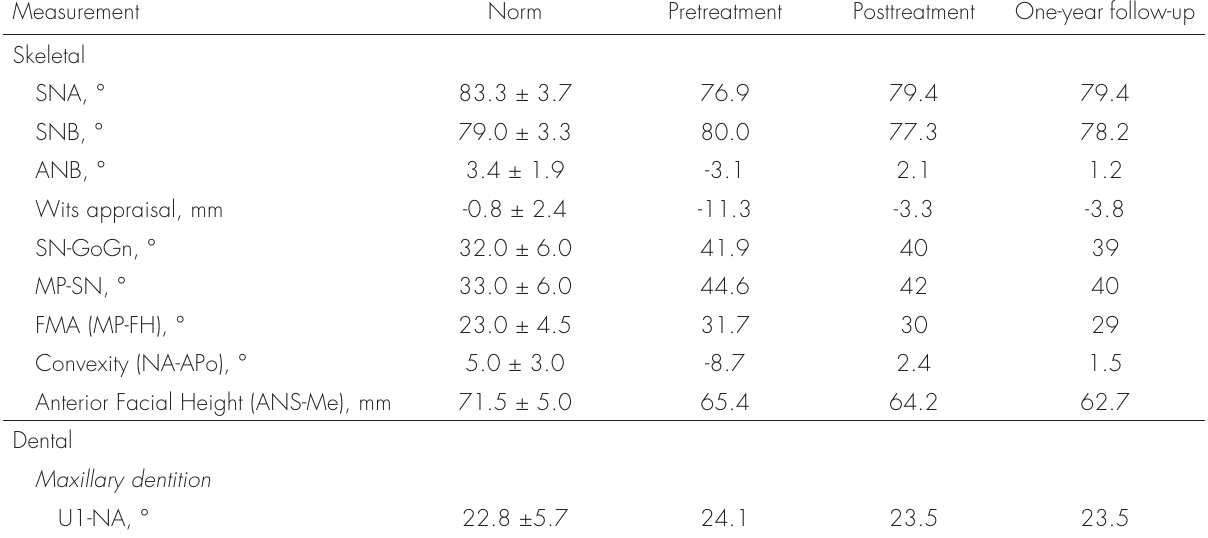
Table I. Cephalometric Analysis. Measurement